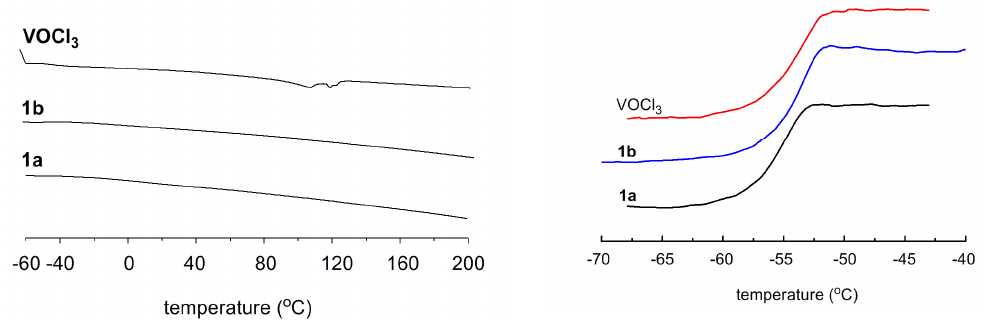
Figure 4. DSC curves of ethylene/propylene copolymers obtained with vanadium-based catalysts ( left , VOCl 3 , Run 3; 1a , Run 6; 1b , Run 10 in Table 1) and partly enlarged curves ( right ).